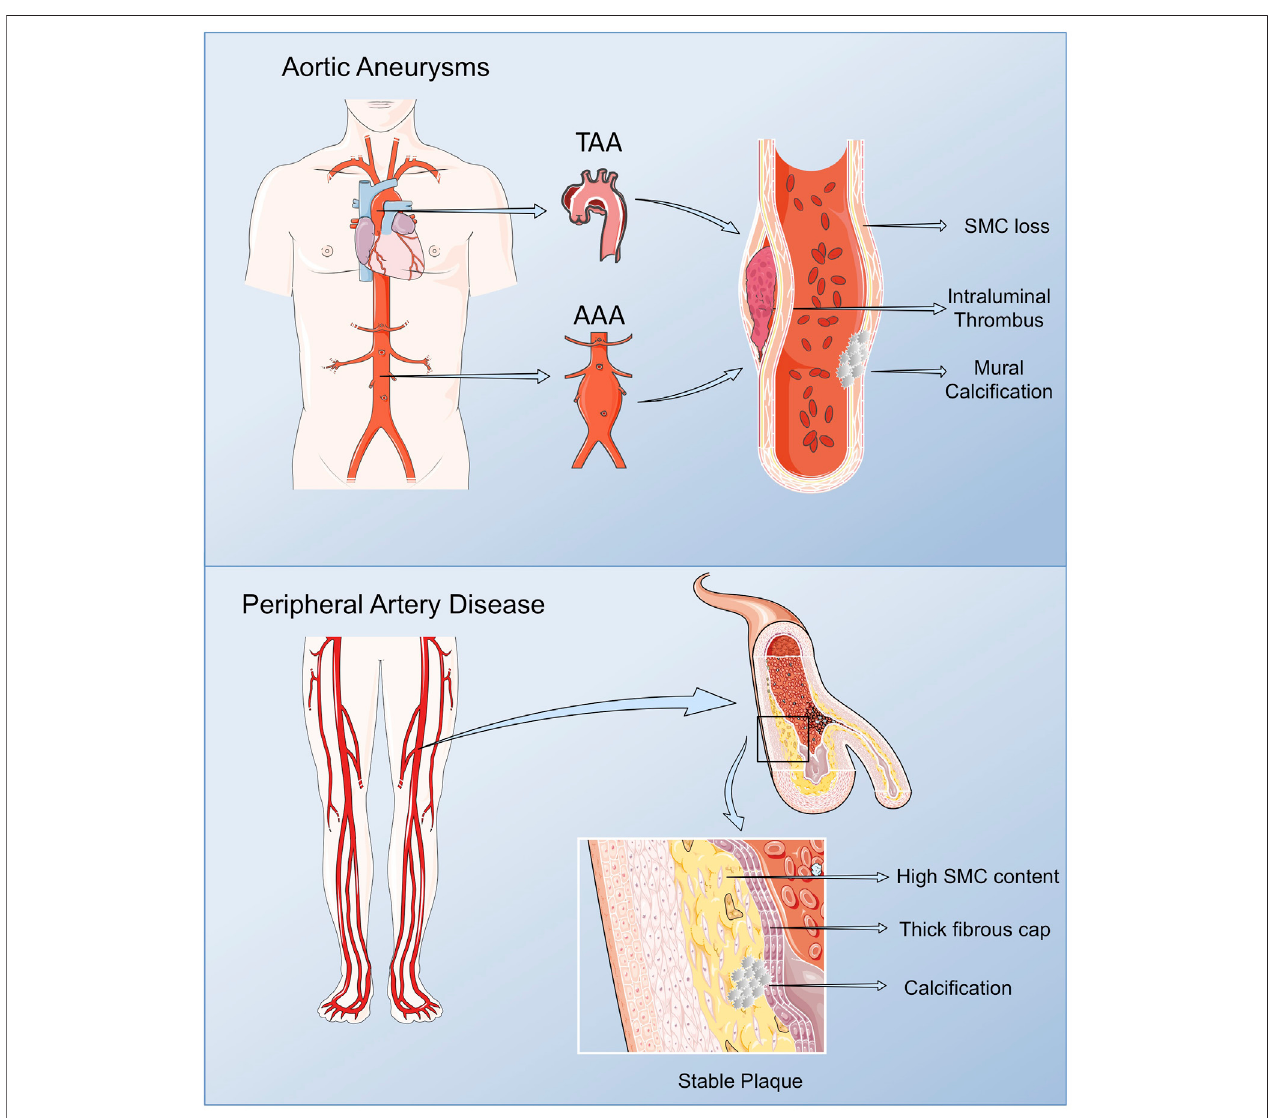
FIGURE1 | Pathological vascular remodeling. Arterial remodeling in peripheral arteriesand thoracic and abdominal aortas presentsome phenotypic particularities comparedwithvascularlesionsinothervascularbeds.Lowerlimblesionsaremostfrequentlystable withlowmacrophagecontent,andaprevalenceofvascularSMCs, resulting in plaques rich in collagen and elastic fi bers, mostly calci fi ed, with a non-signi fi cant lipid core. AAAs are characterized by the presence of an Intra Luminal Thrombus (ILT), rich in red blood cells (RBCs), neutrophils and platelets, and an aortic wall with low number of vascular SMCs in the remaining media, along with immunecellin fi ltrates, fi broblasts and neovesselsintheadventitia.TAAdisplay extensiveremodelingoftheECM, vascularSMCsdysfunctionand calci fi cation, but ILTis not present. Figure created using Servier Medical Art images (https://smart.servier.com).